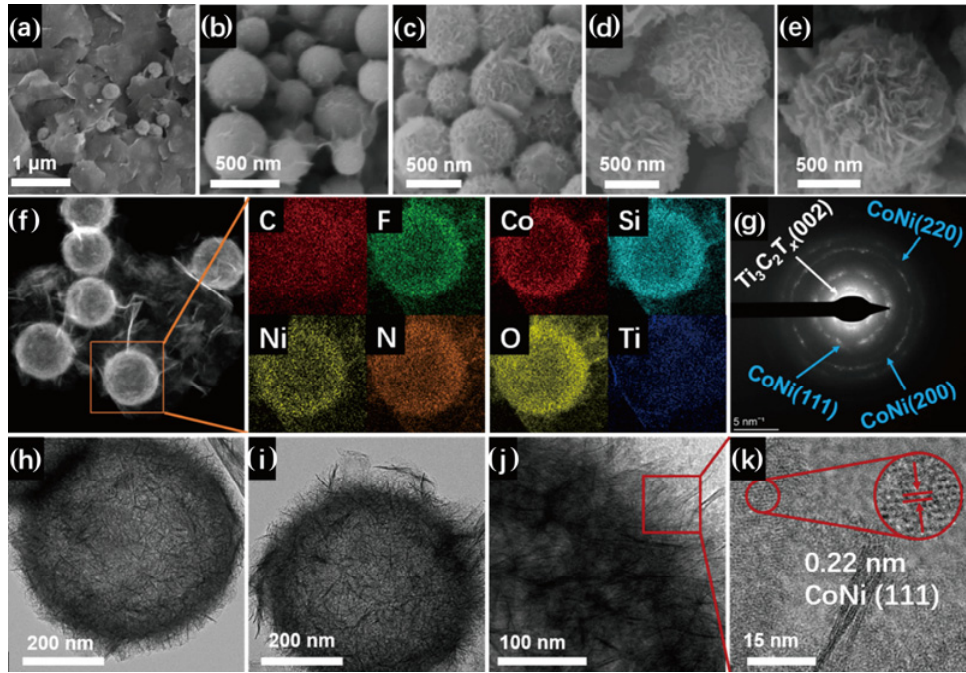
Fig. 3 SEM images of (a) 2D Ti 3 C 2 T x @CoNi nanosheets, (b) core–shell structured SiO 2 @Ti 3 C 2 T x microspheres, and SiO 2 @Ti 3 C 2 T x @CoNi microspheres with CoNi alloy of different thicknesses T CoNi = (c) 110, (d) 250, and (e) 400 nm. (f) Elemental energy dispersive spectroscopy (EDS) mapping analysis of SiO 2 @Ti 3 C 2 T x @CoNi microspheres. (g) Selected area electron diffraction (SAED) patterns of SiO 2 @Ti 3 C 2 T x @CoNi microspheres. (h–j) TEM and (k) high-resolution TEM (HRTEM) images of SiO 2 @Ti 3 C 2 T x @CoNi